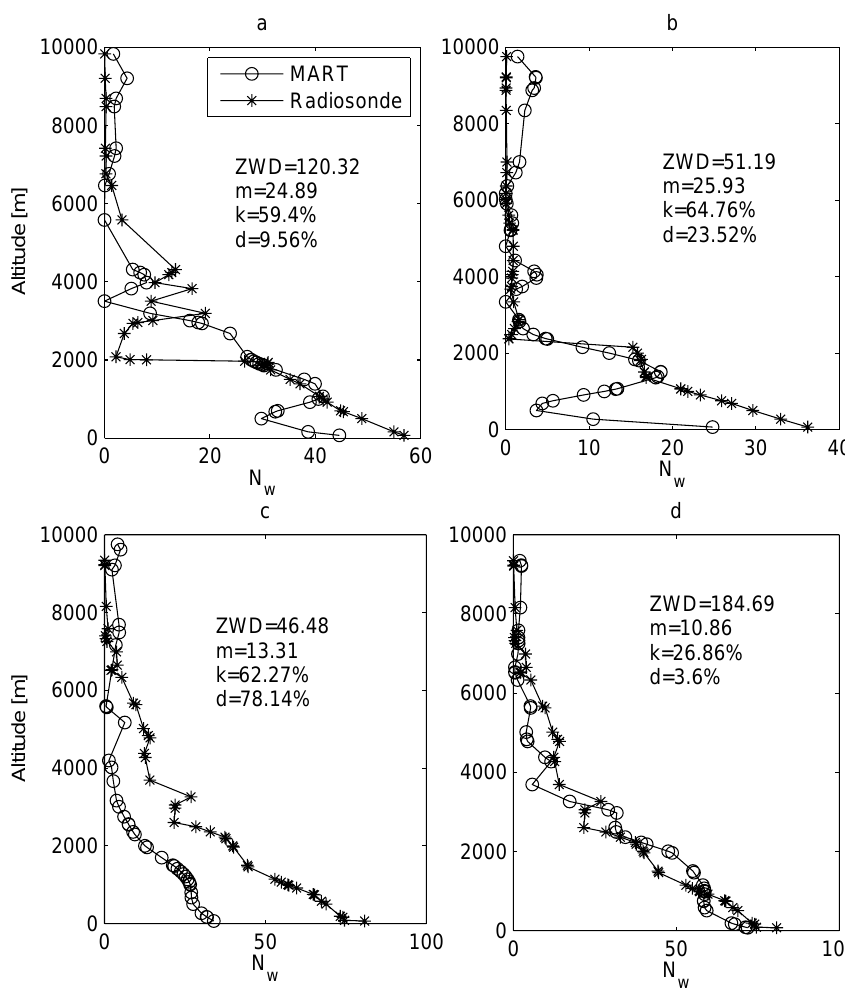
Fig. 10. Example profiles for the different quality classes, poor ( a , b , c ) and good (d) .